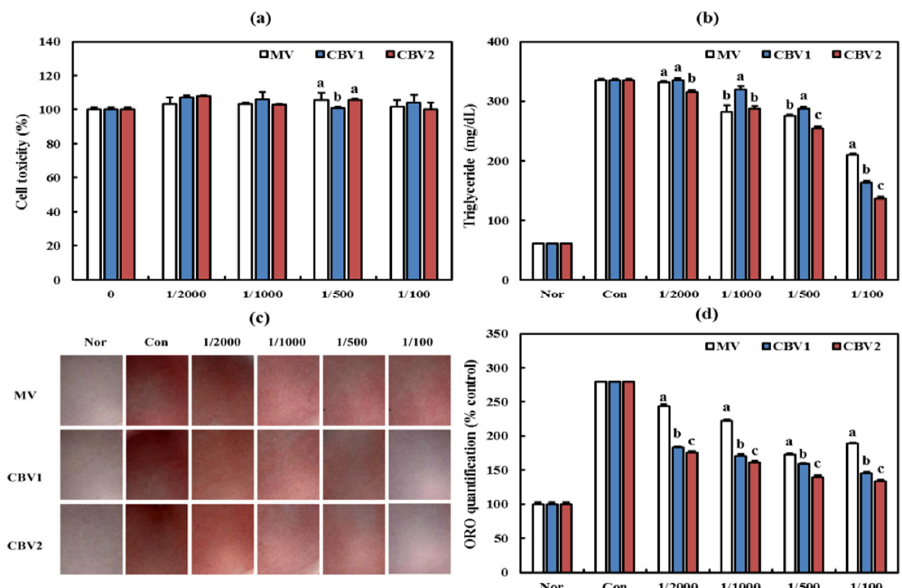
Figure 3. Anti-obesity activities of CBVs in 3T3-L1 cells. ( a ) Cytotoxicity. ( b ) Concentration of intracellular triglycerides. ( c ) Oil red O staining. ( d ) Quantification of Oil red O staining. Data are expressed as the mean ± SD. Lowercase letters indicate significant differences between groups ( p < 0.05). MV—mandarin vinegar; CBV1—blended mandarin vinegar and premature mandarin vinegar in a ratio of 8:2; CBV2—blended mandarin vinegar and premature mandarin vinegar in a ratio of 7:3.